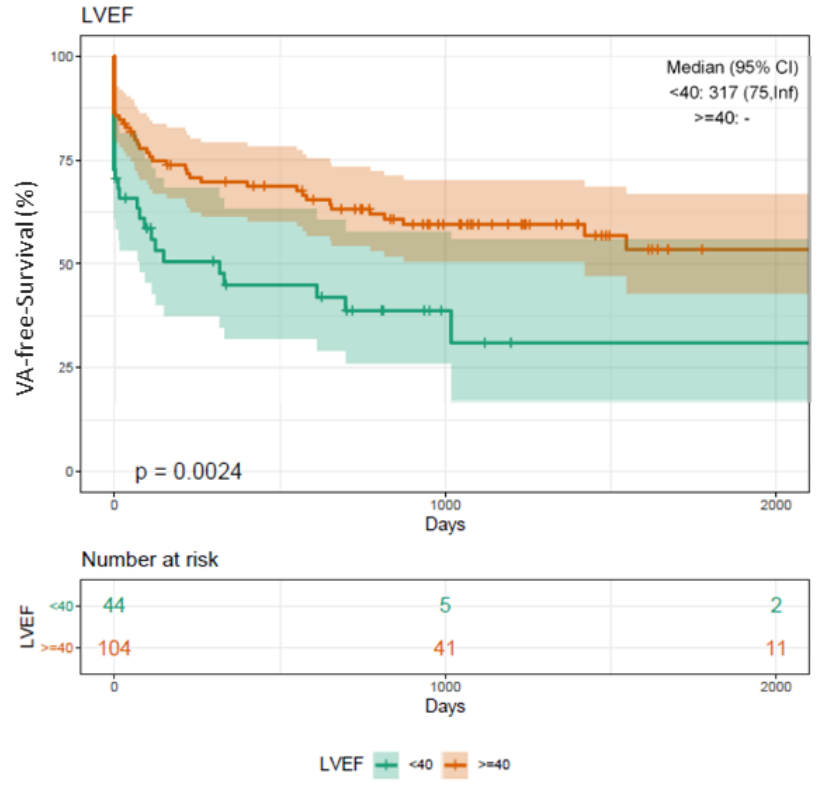
Figure 2. Kaplan–Meier plot on freedom from VA recurrence in patients undergoing RMN ablation depending on LVEF. Patients undergoing RMN ablation for VA with a highly reduced LVEF below 40% present with a significantly worse outcome compared to patients with an LVEF function accounting for more than 40% (Log-rank p -value = 0.002*). VA, ventricular arrhythmia; VT, ventricular tachycardia; PVC, premature ventricular contractions; RMN, remote magnetic navigation; LVEF, left ventricular ejection fraction; FU, follow-up.